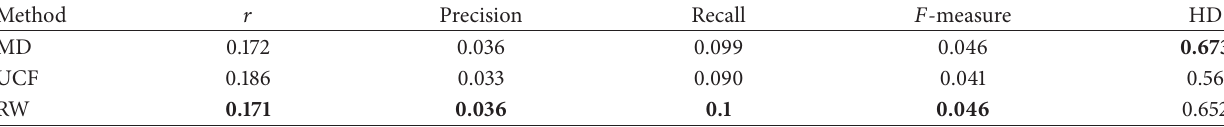
Table 2: Algorithmic performance for Epinions data set with recommendation list 𝐿 = 20 .